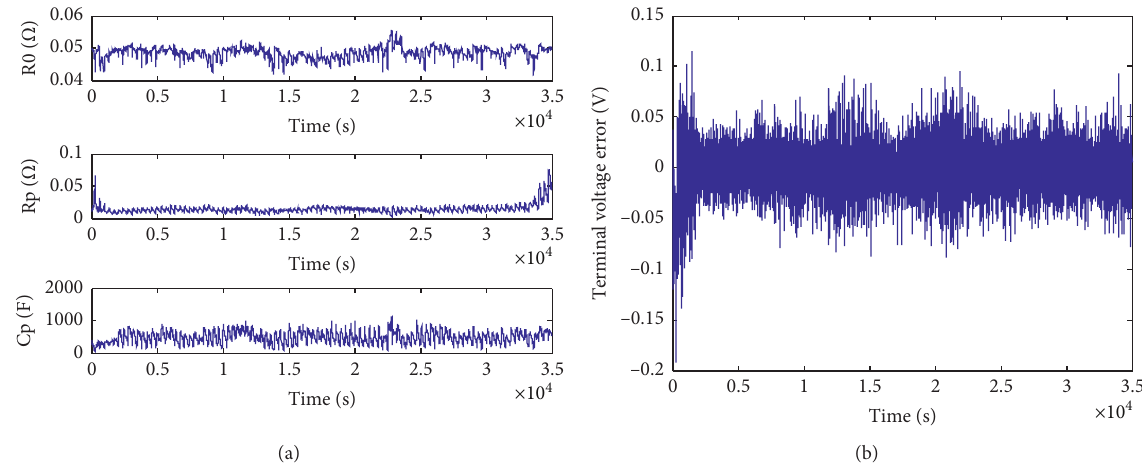
Figure 8: Model parameters identification results under DST: (a) R0 Rp Cp; (b) terminal voltage error.